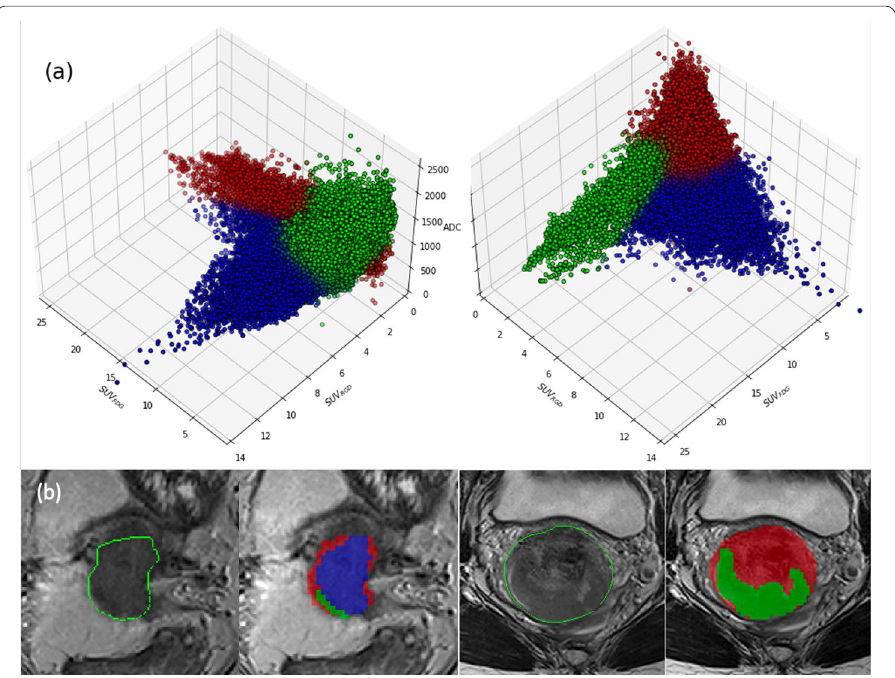
Fig. 4 3D scatter plot of the multi-parametric data representing the clusters fitting with a Gaussian mixture model ( a ). The clusters are mapped back to the T2-weighted MRI images for two representative patients ( b